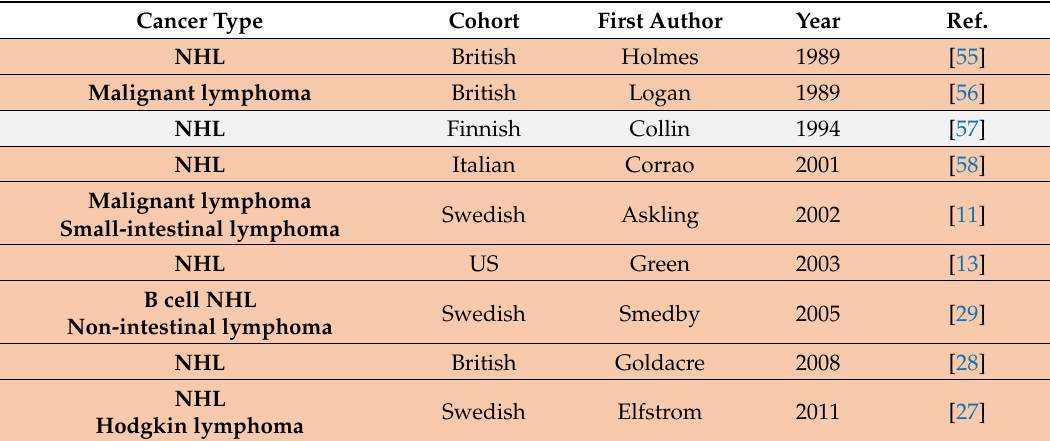
Table 3. Studies examining lymphoma risk in CD patients.